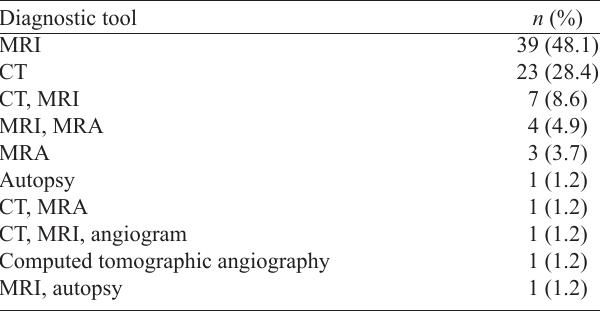
Table 3. Diagnostic tools for cerebral infarct in 81 patients.